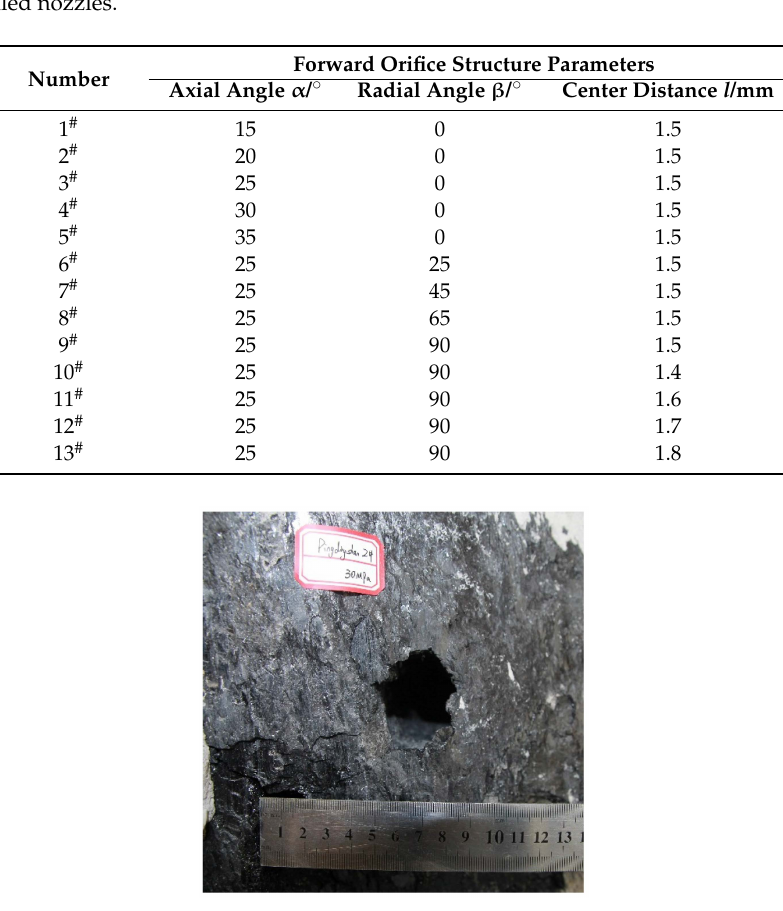
Table 1. Axial and radial angles and center distance offsets of the forward orifices for thirteen self-propelled nozzles.